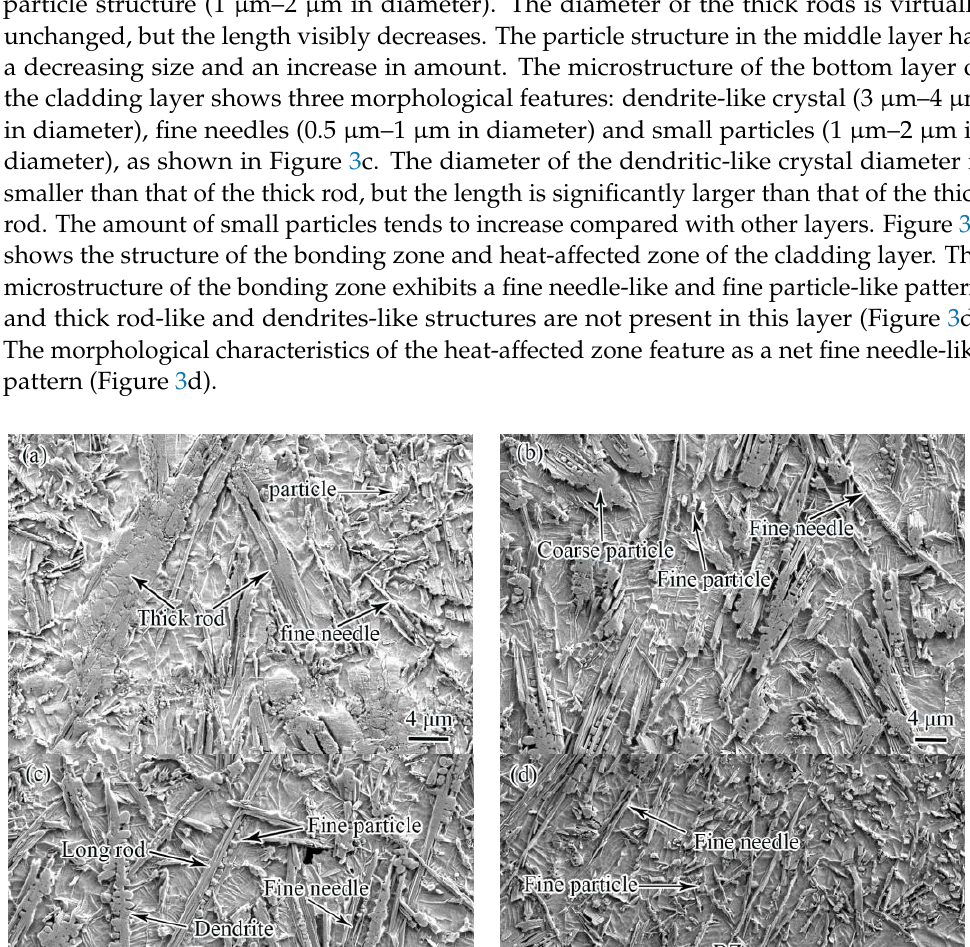
Figure 2. Macroscopic morphology ( a ) and microstructure ( b ) of the cross section of laser cladding layer (CZ — cladding zone, BZ — bonded zone, HAZ — heat affected zone, SUB — substrate).